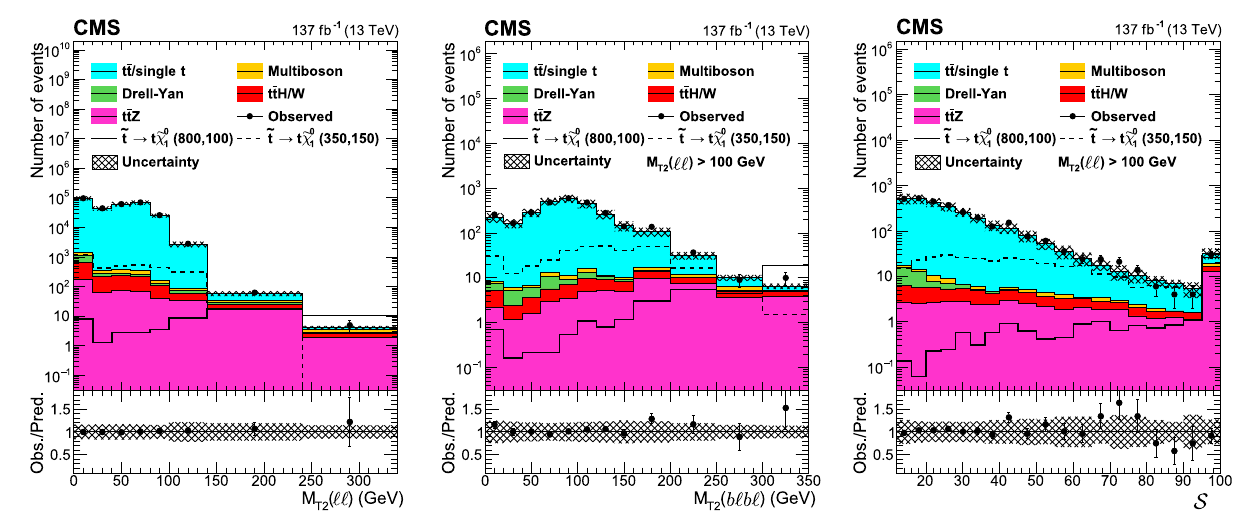
Fig. 4 Distributions of M T2 ((cid:5)(cid:5)) (left), M T2 ( b (cid:5) b (cid:5)) (middle), and S (right) for all lepton flavors for the preselection defined in Table 2. Additionally, M T2 ((cid:5)(cid:5)) > 100GeV is required for the M T2 ( b (cid:5) b (cid:5)) and S distributions. The last bin in each distribution includes the overflow